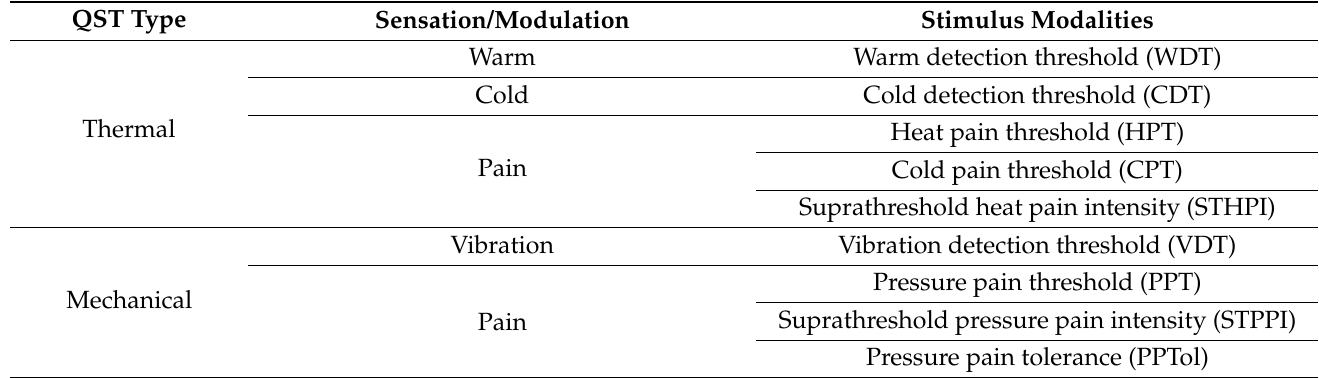
Table 1. Type of assessment of stimulus modalities by quantitative sensory testing